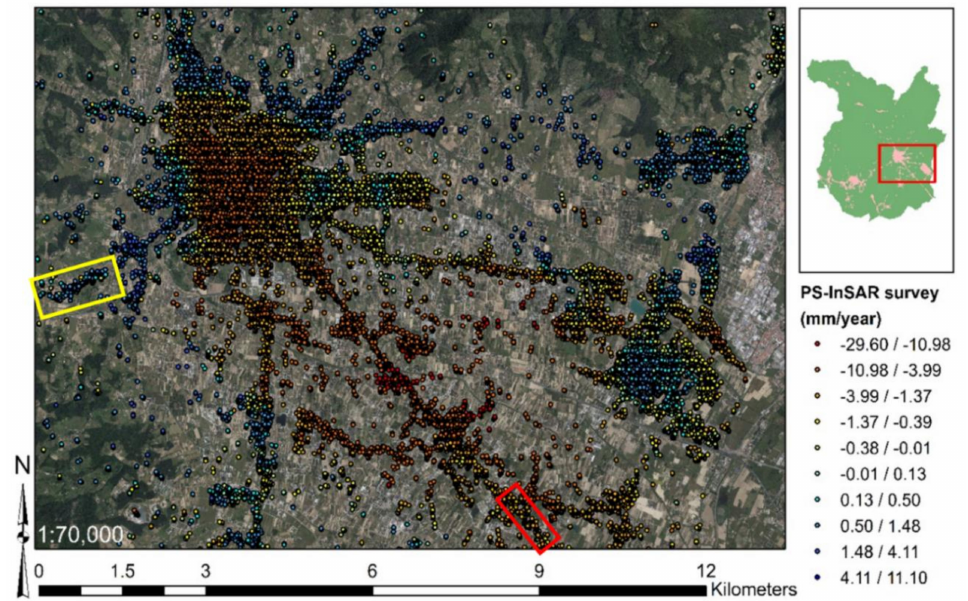
Figure 6. Map of surface motion over the city of Pistoia, based on “natural breaks” (ESRI ArcGIS 10.5). Adapted from Fiorentini et al.